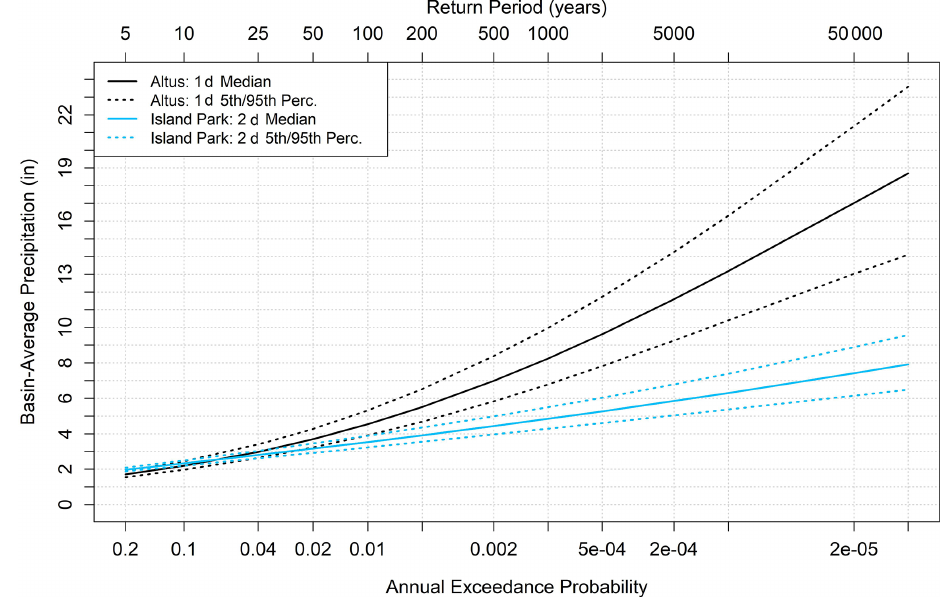
Figure 4. Precipitation frequency estimates for Altus (1d; blue) and Island Park (2d; black) including the median (solid), and the 5th and the 9th percentiles (dashed). Table 2. Parameters used to define the four-parameter Kappa distribution. Table is reproduced from Table 4.5 in Reclamation (2016a).